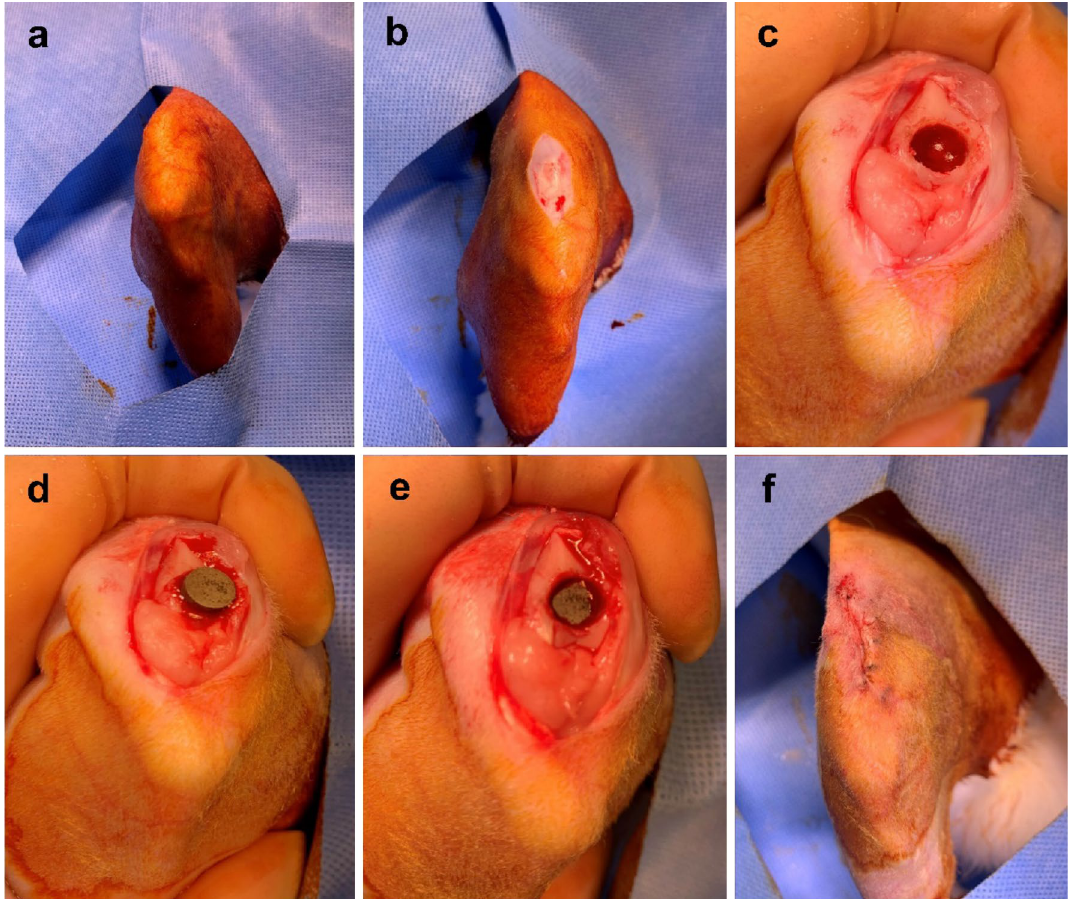
Figure 6. Surgical procedure for implanting specimens into rabbit trochlear grooves. ( a ) The right knee of each rabbit was shaved and sterilized with povidone–iodine. ( b ) In the supine position, the right legs were incised longitudinally from 2 cm above the knee joint to 1.5 cm below. ( c ) A hole with a 6 mm trephine burr was created on the proximal side of the trochlear groove. ( d ) A specimen was placed in the hole with the porous surface facing the cancellous bone. ( e ) The specimen was gently impacted to facilitate contact with the cancellous bone. ( f ) Patella reduction was performed and the incision was Normal saline was sprayed during the reaming procedure to prevent thermal injuries around the bone and soft tissue. An experimental specimen was placed in the hole of the trochlear groove with the porous surface facing the cancellous bone (Fig. 6d). We gently impacted the specimen to facilitate contact with the cancellous bone (Fig. 6e). After implantation, patella reduction was performed. After checking the reduction status and knee motion, we repaired the joint capsule and subcutaneous tissue with Vicryl 2-0 (Fig. 6f). Finally, the wound was disinfected with povidone–iodine 41 . Postoperative care and sacrifice. After surgery, experimental rabbits were administered 0.6 mL/kg of cefazoline (Chongkundang, Seoul, Korea) and 1.8 mL/kg ketoprofen (UNIBIO tech, Seoul, Korea) intramuscu- larly thrice daily for 3 days. The rabbits were allowed to act freely within their cages after surgery. Subsequently, the rabbits were sacrificed after the planned number of weeks following implantation surgery. We injected keta- mine (700 μL/kg) and xylazine hydrochloride (400 μL/kg) intramuscularly; this was followed by an intravenous injection of potassium chloride. Then, the right side of the distal femur was harvested, and the specimens were fixed in 10% neutral buffered formalin (Sigma-Aldrich Corp., St. Louis, MO, USA) for 2 weeks.. Histologic slide manufacturing and staining. Specimens were cleaned with distilled water, and decal- cification was performed using ethylenediaminetetraacetic acid (EDTA) solution (pH 9.0) (Zytomed systems GmbH, Berlin, Germany) for 5 weeks. After confirming the removal of calcium, the specimens were embedded in paraffin and sectioned to a thickness of 50 µm with a hard tissue slicer (Struers, Willich, Germany) 47 . The sections were stained with hematoxylin and eosin (Sigma-Aldrich) and Masson’s trichrome (Sigma-Aldrich) stain to visualize the contact surface and osseointegration. General specimen imaging and histomorphometric analyses were conducted at 40 × magnification (Supplementary Fig. S6) 41 .